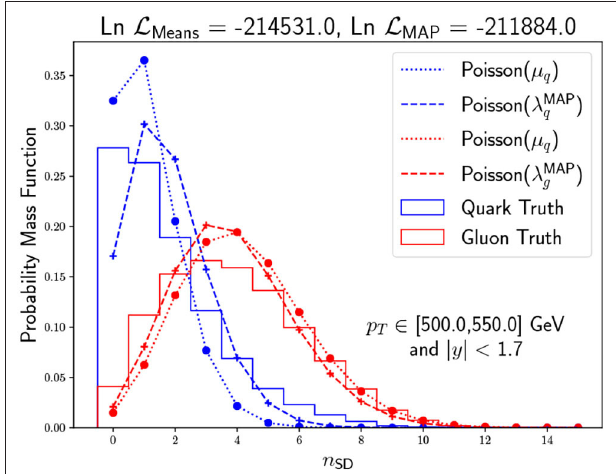
FIGURE 8 | n SD distribution comparison between pseudo-data generated through MC (solid) and Poissonians estimates using as rates the mean of the data (dashed) and the Maximum a Posteriori MAP from the Bayesian inference (dashed). We see that the Poissonian approximations are good enough to distinguish quark from gluon, but there are slight differences when comparing each approximation to its corresponding data.